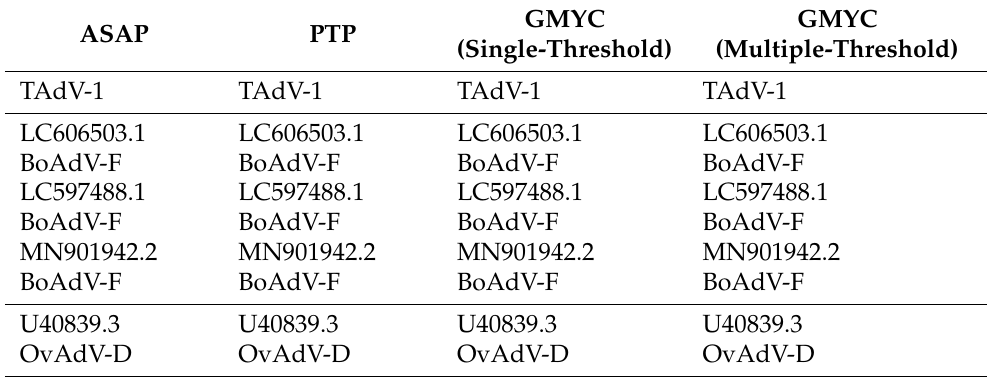
Table 3. Species delimitation schemes were obtained using the ASAP, PTP and GMYC approach. The following abbreviations are used: Bovine adenovirus F (BoAdV-F), Ovine atadenovirus D (OvAdV-D), Deer atadenovirus A (OdAdV-A), Bovine atadenovirus D (BoAdV-D), Bovine atadenovirus E (BoAdV-E), Lizard atadenovirus B (LiAdV-B), Lizard atadenovirus A (LiAdV-A), Psittacine atadenovirus A (PsAdV-A), Duck atadenovirus A (DAdV-A). The last row contains the total number of partitions obtained when analyzing 26 representatives of the Atadenovirus